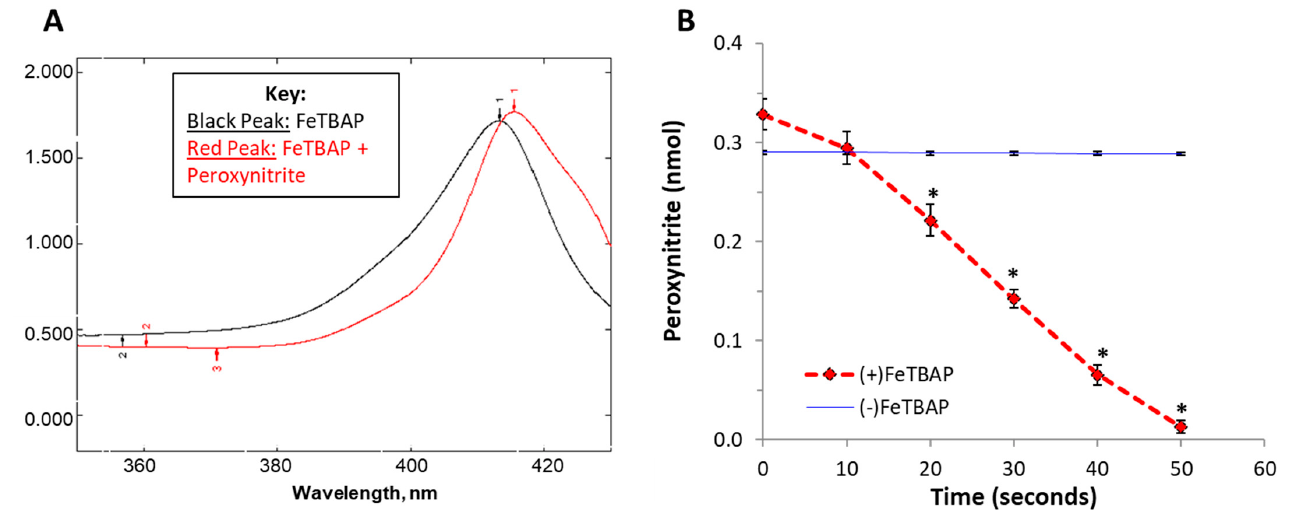
Figure 2. FeTBAP acts as a peroxynitrite decomposition catalyst. ( A ) Absorbance spectra of 20 µM FeTBAP before (black curve) and after (red curve) the addition of 300 µM peroxynitrite. ( B ) Peroxynitrite composition monitored at 302 nm for 20 µM FeTBAP. * p < 0.05 versus control without FeTBAP, n = 3–4/group.